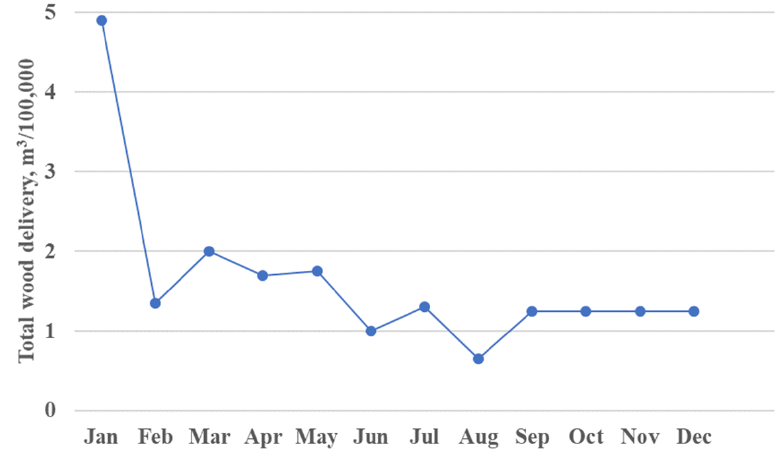
Figure 4. Dynamics of wood deliveries and steady state of wood procurement at end of 2017.